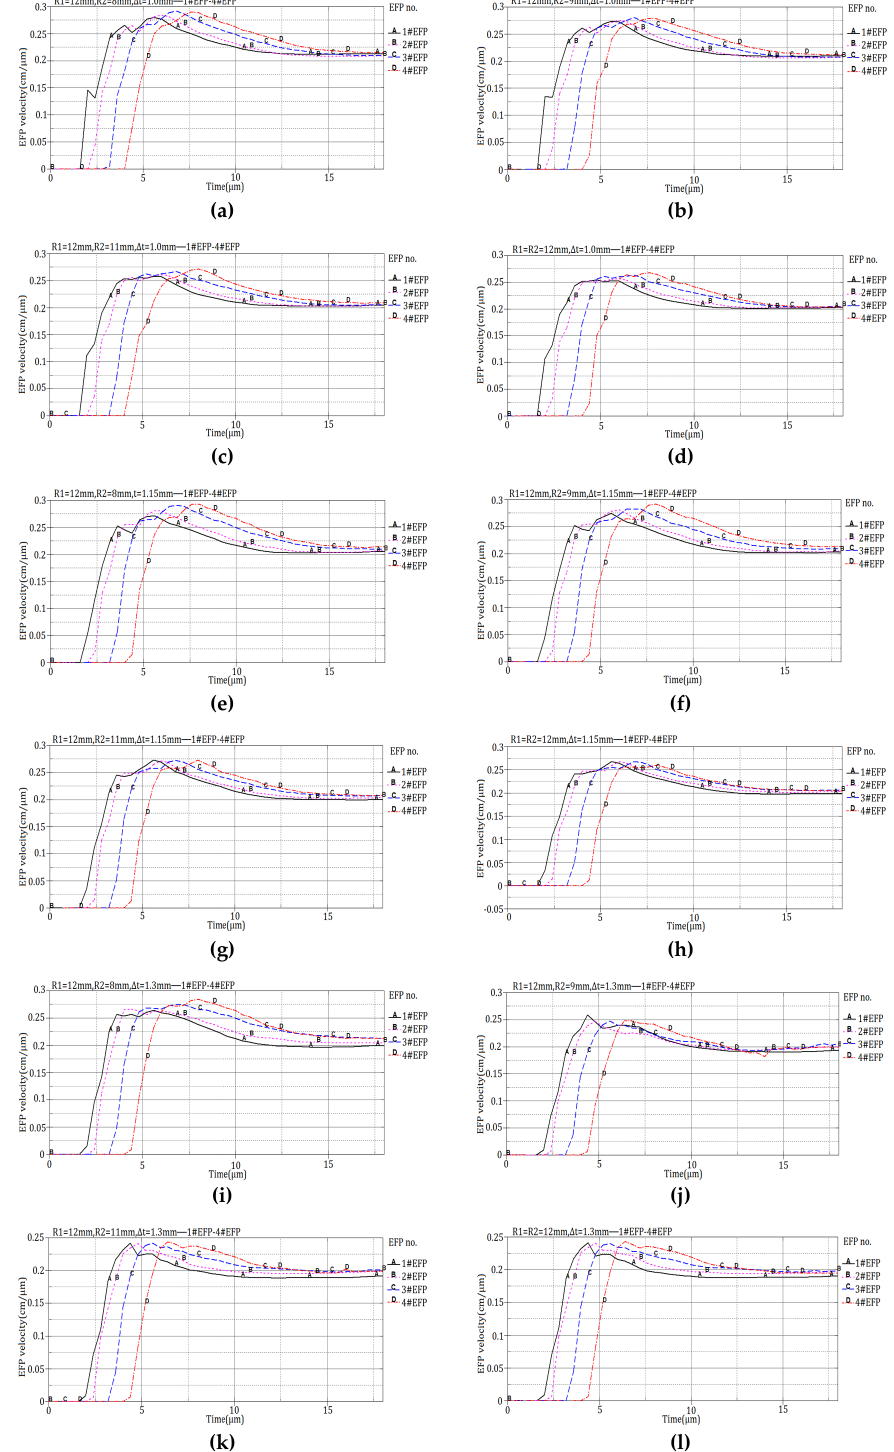
Figure 14. 1#EFP-4#EFP formed velocity of the liner which di ff erent curvature radius of outer wall and di ff erent center thickness:( a ) R1 = 12 mm, R2 = 8 mm, ∆ t = 1.0 mm; ( b ) R1 = 12 mm, R2 = 9 mm, ∆ t = 1.0 mm; ( c ) R1 = 12 mm, R2 = 11 mm, ∆ t = 1.0 mm; ( d ) R1 = R2 = 12 mm, ∆ t = 1.0 mm; ( e ) R1 = 12 mm, R2 = 8 mm, ∆ t = 1.15 mm; (f) R1 = 12 mm, R2 = 9 mm, ∆ t = 1.15 mm; ( g ) R1 = 12 mm, R2 = 11 mm, ∆ t = 1.15 mm; ( h ) R1 = R2 = 12 mm, ∆ t = 1.15 mm; ( i ) R1 = 12 mm, R2 = 8 mm, ∆ t = 1.3 mm; ( j ) R1 = 12 mm, R2 = 9 mm, ∆ t = 1.3 mm; ( k ) R1 = 12 mm, R2 = 11 mm, ∆ t = 1.3 mm; ( l ) R1 = R2 = 12 mm, ∆ t = 1.3